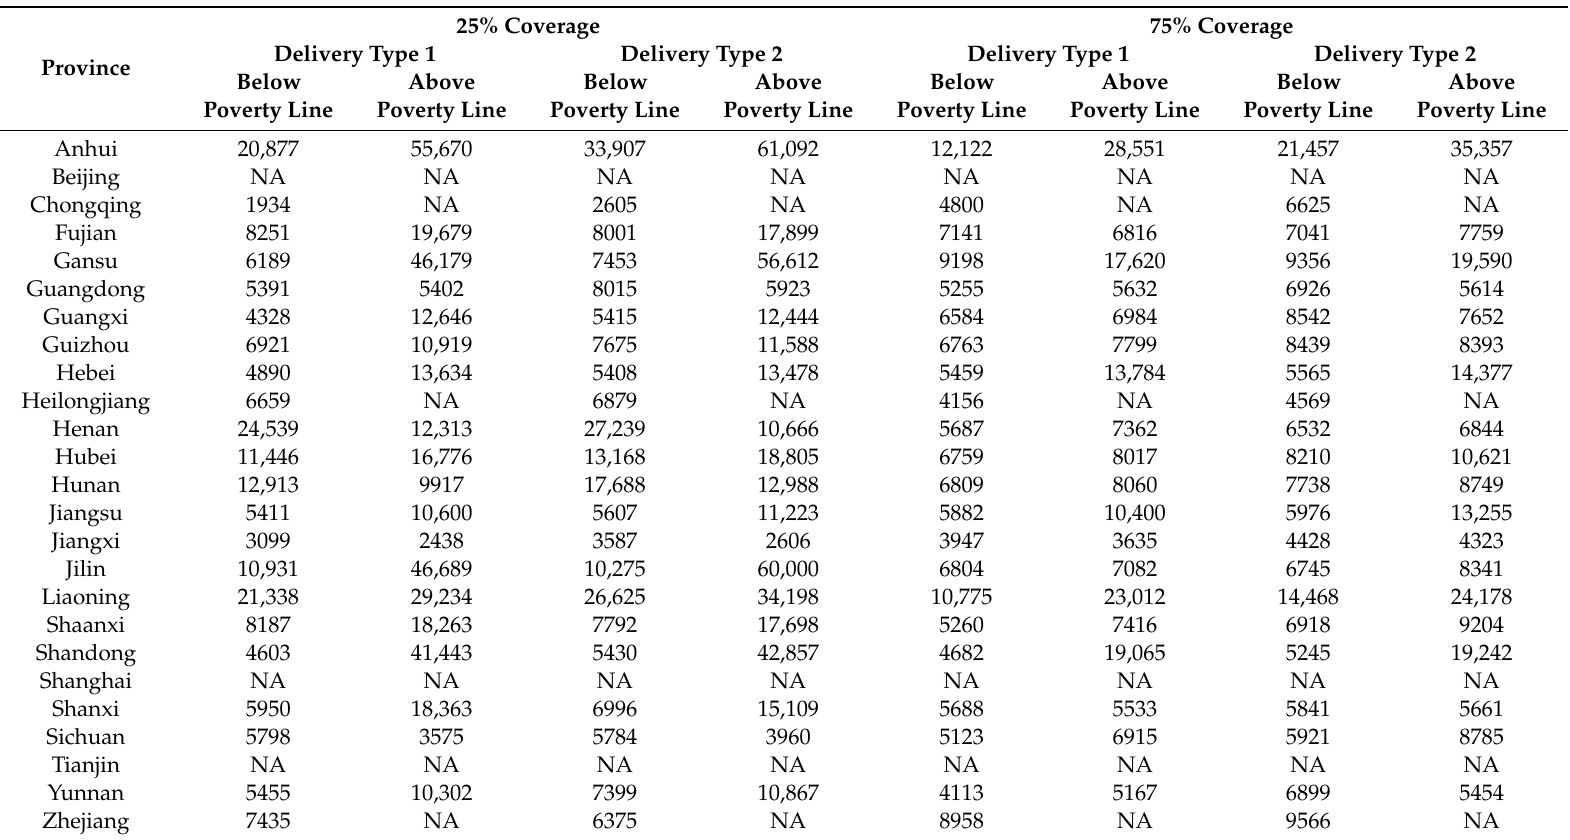
Table 4. Cost-e ff ectiveness of YYB program, by province and poverty status, when the e ff ect size of YYB is reduced to 0.96 cm (Cost (¥) per stunting case averted).